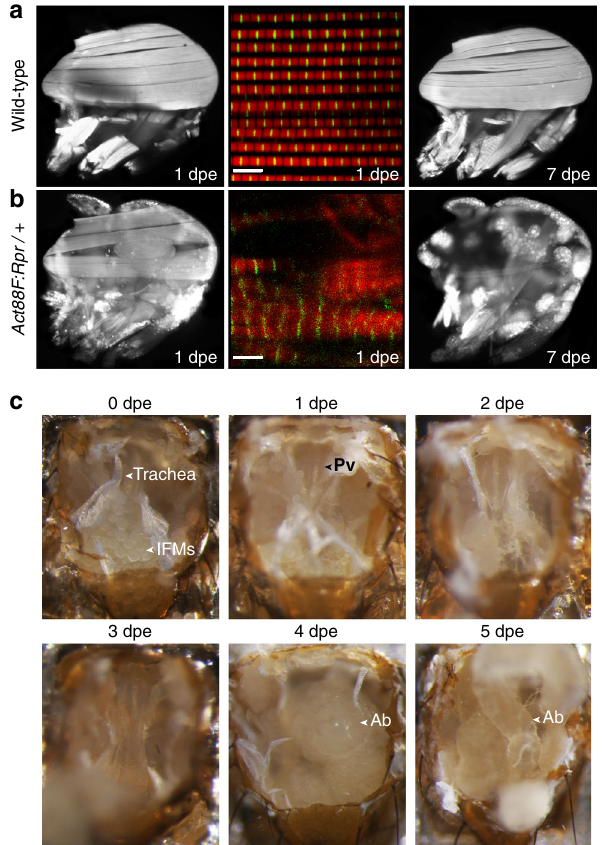
Fig. 6 Indirect fl ight muscle degradation in Act88F:Rpr animals. Confocal images of dorsal longitudinal IFMs (DLMs) stained with TRITC-Phalloidin at 1 dpe (left), 7 dpe (right), or whole-mount confocal micrographs of myo fi brillar structure (middle) for a wild-type, or b Act88F:Rpr heterozygous fl ies. Scale bars are 5 μ m. c IFM degradation over time in heterozygous Act88F:Rpr animals ( Act88F:Rpr/elav-Gal4; UAS-GCaMP6s/ +